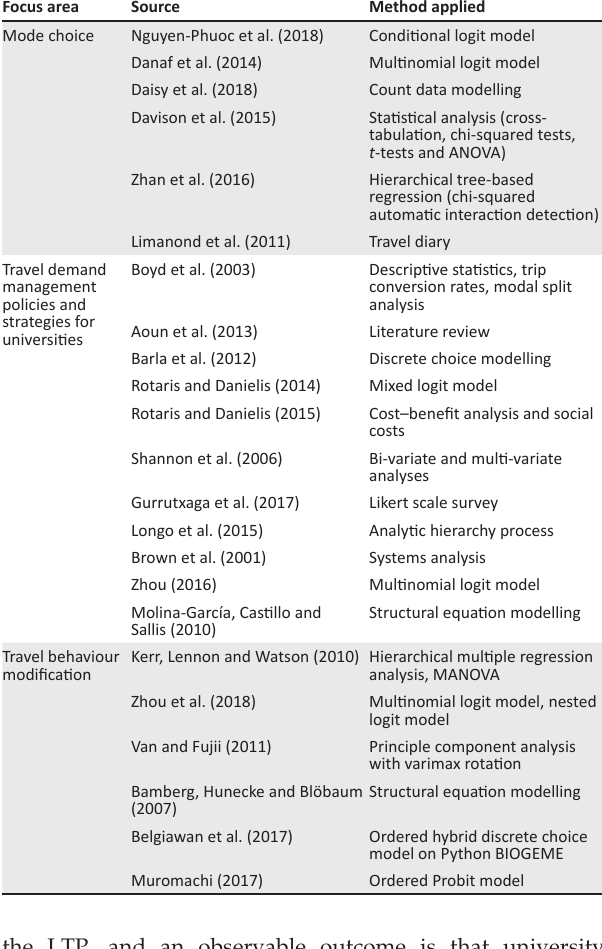
TABLE 3: Literature reviewed by focus area and methods. Focus